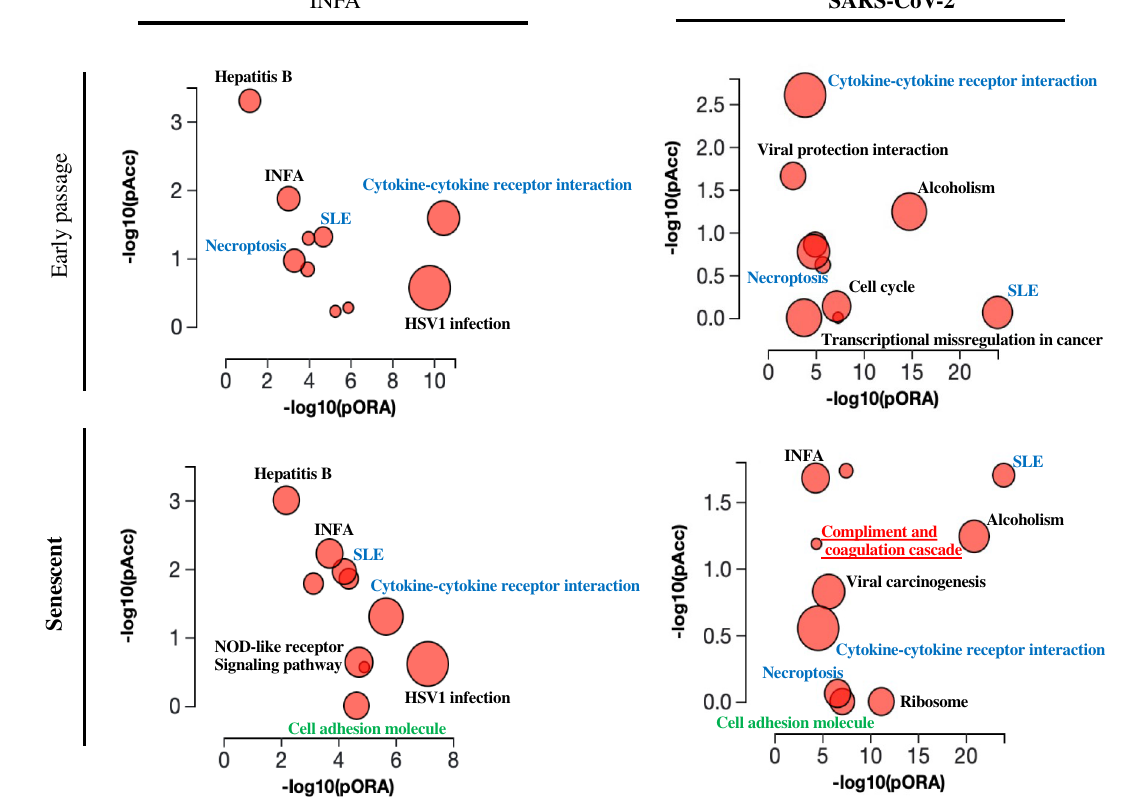
Figure 4. Pathway analysis for the genes whose expression was significantly altered by the virus infection. Pathways affected by the virus infection were analyzed using iPathwayGuide. Dots representing the top 10 impacted pathways are positioned by their p-values from two different analyses; an Impact analysis measuring total perturbation accumulation (pAcc) and an Over-representation analysis (pORA). The size of each dot denotes the total number of genes in the corresponding